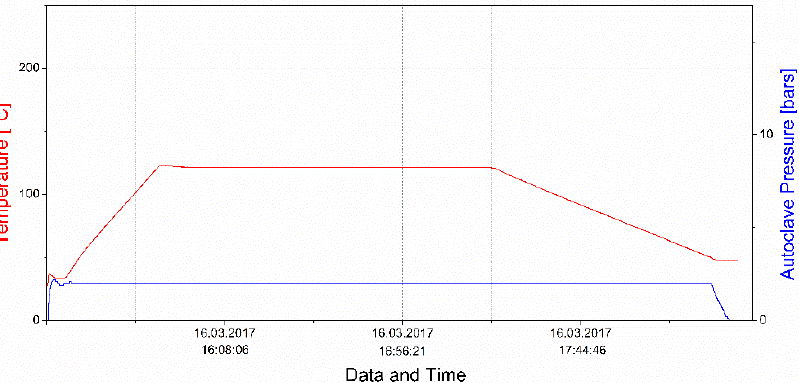
Figure 3. Autoclave thermal and pressure cycle for bonding repair samples with the adhesive FM ®® 300-2.